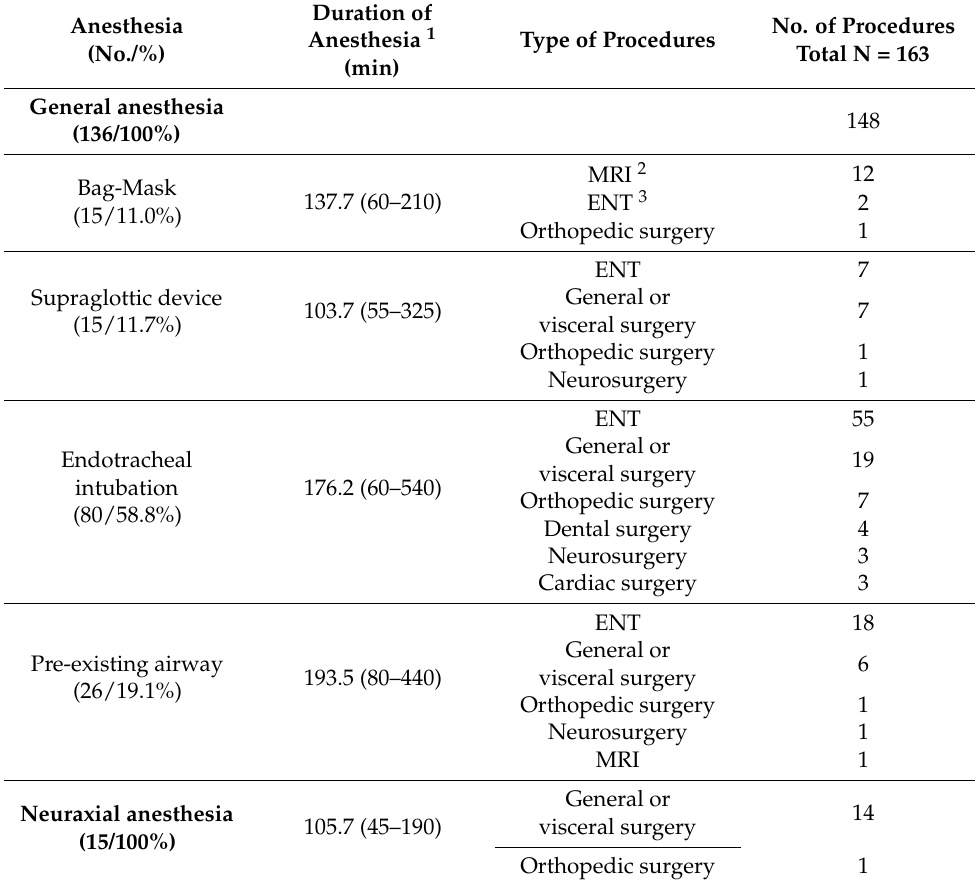
Table 1. Summary of anesthesia methods and intervention